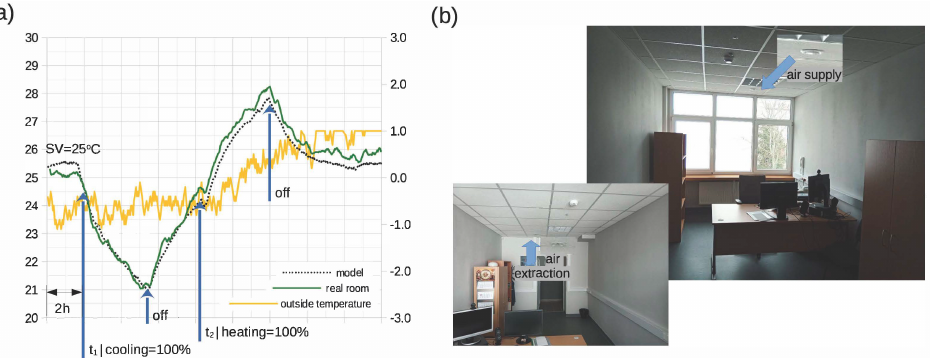
Figure 10. Model verification with the real room. ( a ) The initial temperature was 25 ◦ C , the same as the setpoint (SV). At time t 1 , after 2 h, the cooler was switched on with maximum power. Temperature changes over time were observed. At time t 2 , a similar test was carried out for the heater. The parameters of the model were modified to correspond to the behaviour of a room in a real building, as described in the text. ( b ) The view of the room used to validate the